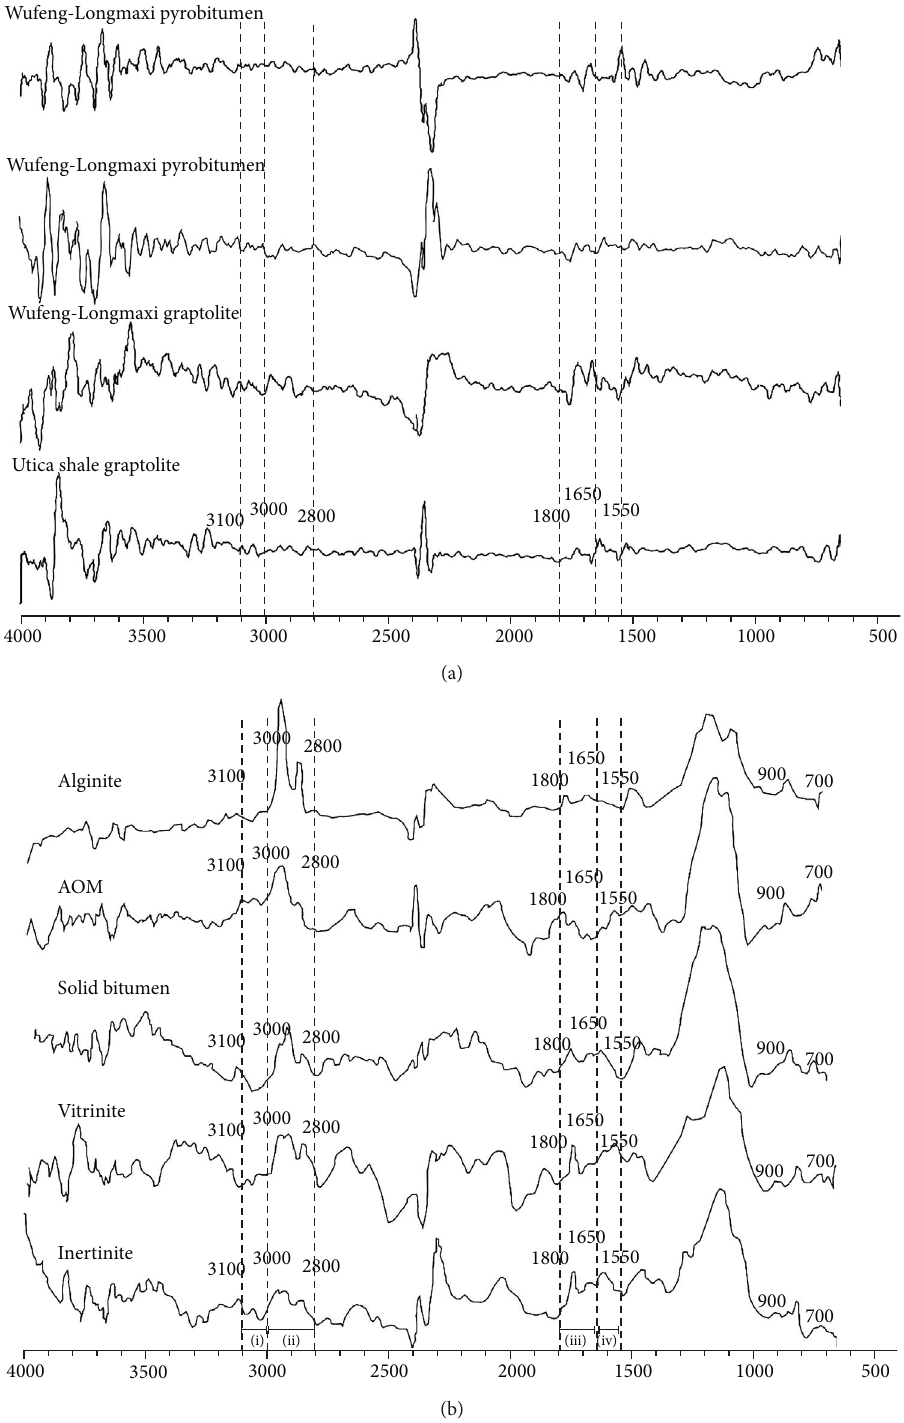
Figure 17: (a) Micro-FTIR spectra of pyrobitumen and graptolite in studied samples. The fi rst two are of pyrobitumen, and the third and fourth show graptolite in Wufeng-Longmaxi shale and Utica shale, respectively. (b) Micro-FTIR spectra of alginite, AOM, solid bitumen, vitrinite, and inertinite from New Albany Shale samples ( VR = 0 : 63 % ) (adapted from o